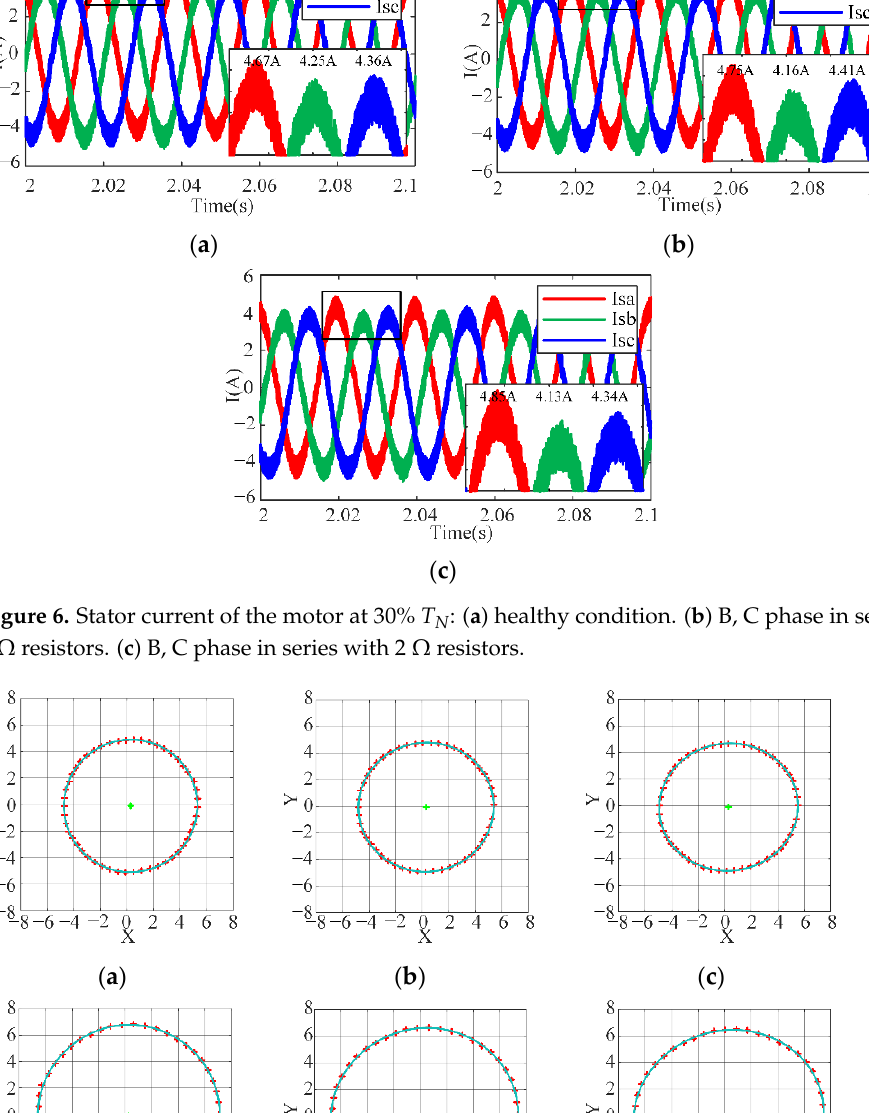
Figure 6. Stator current of the motor at 30% T N : ( a ) healthy condition. ( b ) B, C phase in series with 1 Ω resistors. ( c ) B, C phase in series with 2 Ω resistors.